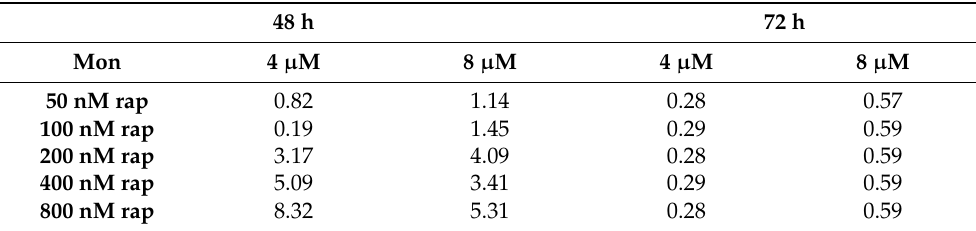
Table 1. The toxic effects of the combination of mon (monensin) and rap (rapamycin) on SH-SY5Y cells were evaluated using the Chou Talalay combination index (CI) at 48 and 72 h. 48 h 72 h